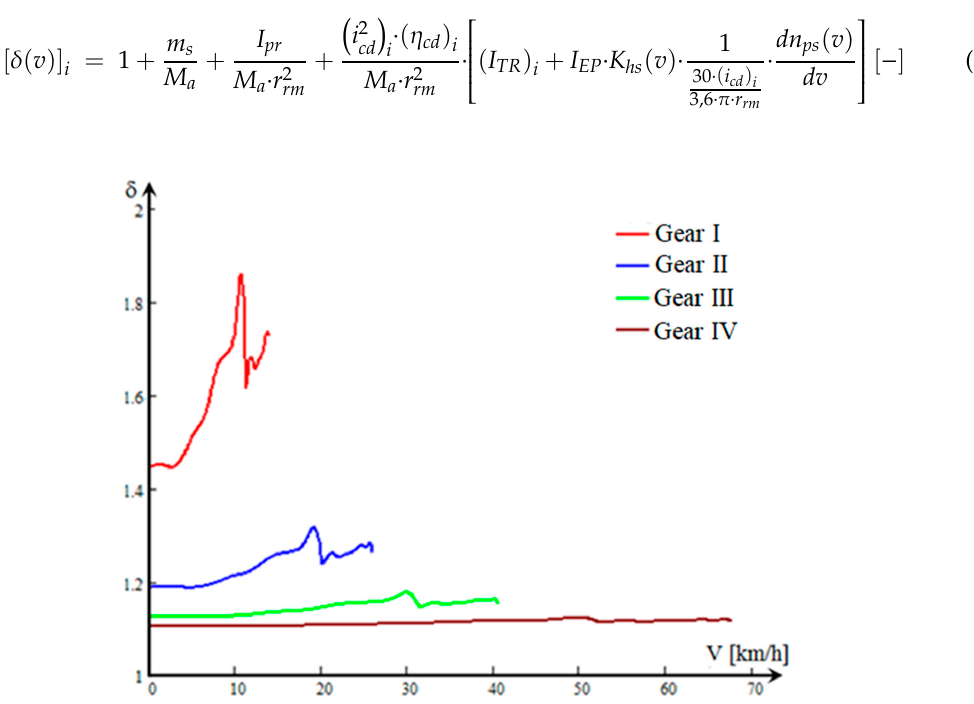
Figure 8. Variation of the mass moment of inertia coefficient ( δ ) depending on the turbine speed.